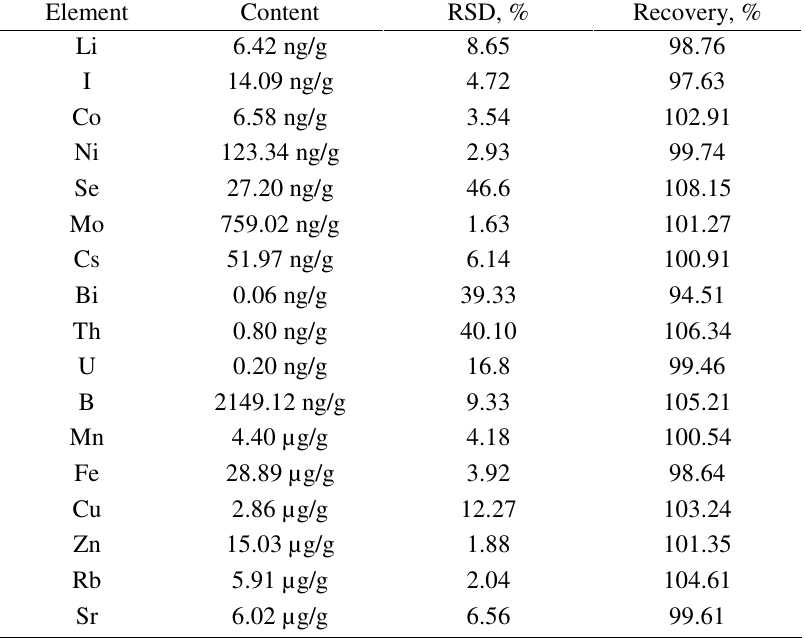
Table 3. Contents and relative standard deviations of trace